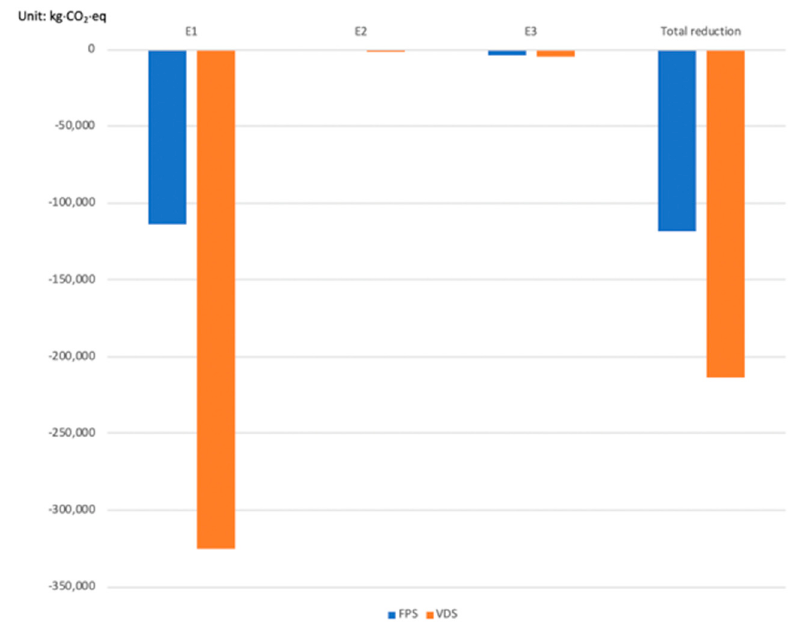
Figure 5. Reduction of CO 2 emissions of the flat plate slab and the voided slab systems.